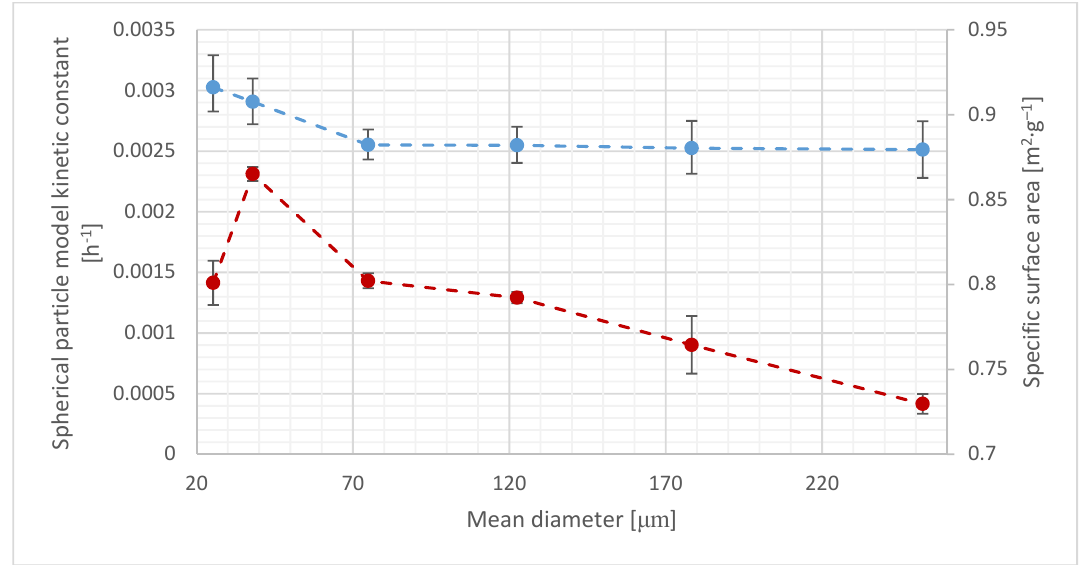
Figure 5. Specific surface area compared to the spherical shaped kinetic constant values. For the k constant (top) and SSA (bottom) data points, the error bars represent the 95% confidence interval and the standard error, respectively.